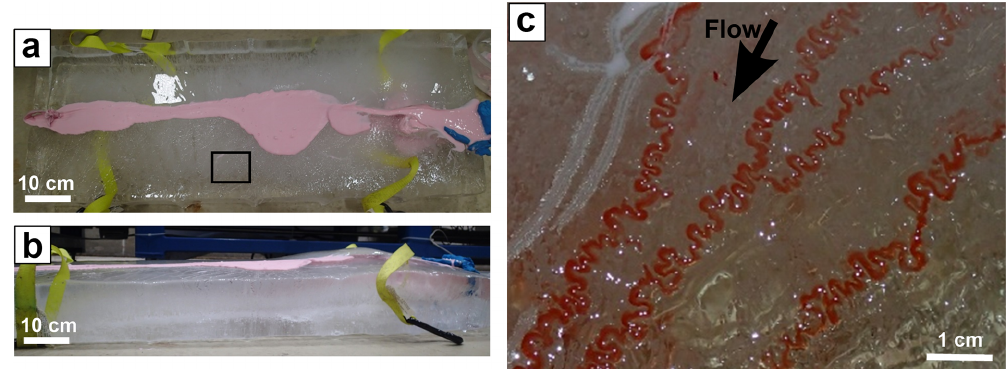
Figure 3. (a) Top and (b) side view of an ice block over which (c) the first set of millimeter-scale self-formed meltwater meanders were observed. The area shown in (c) corresponds to region indicated in (a) . Images in (a) and (b) were taken before adding